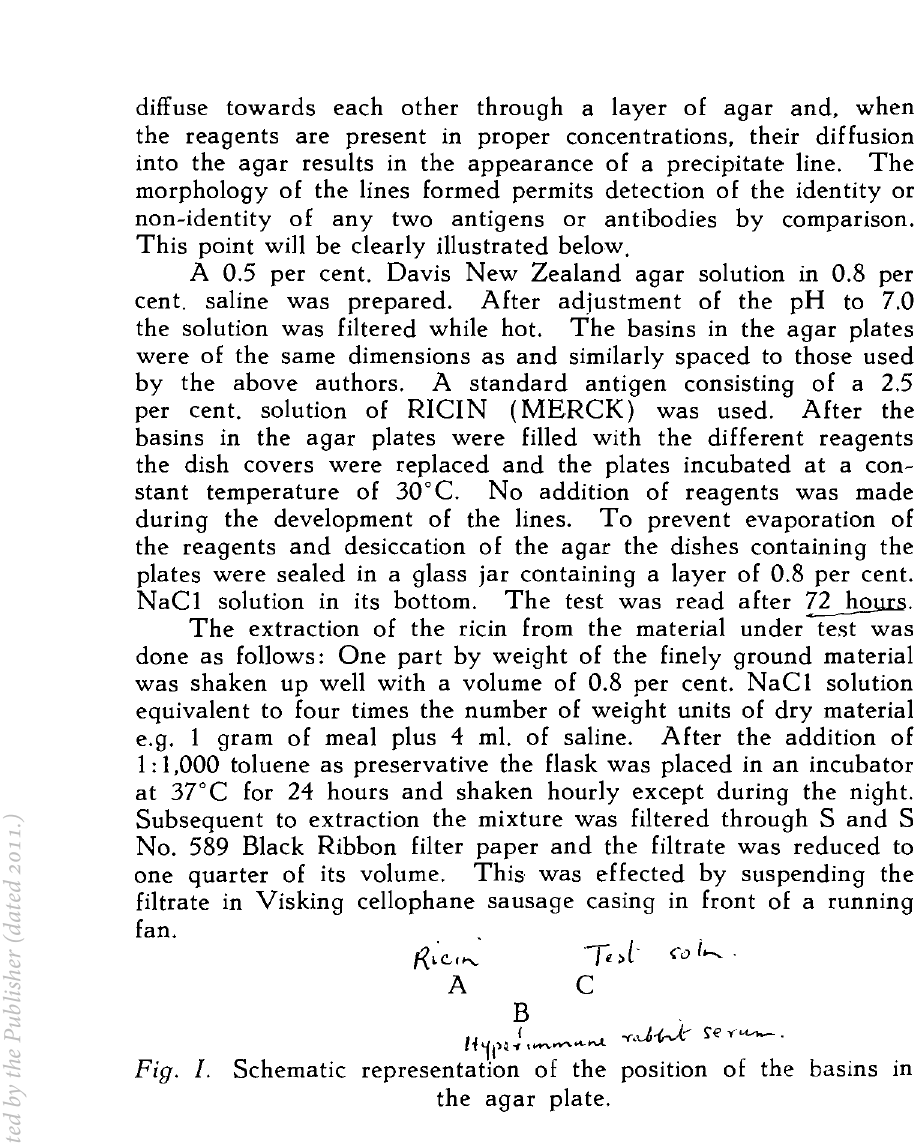
Fig. I. Schematic